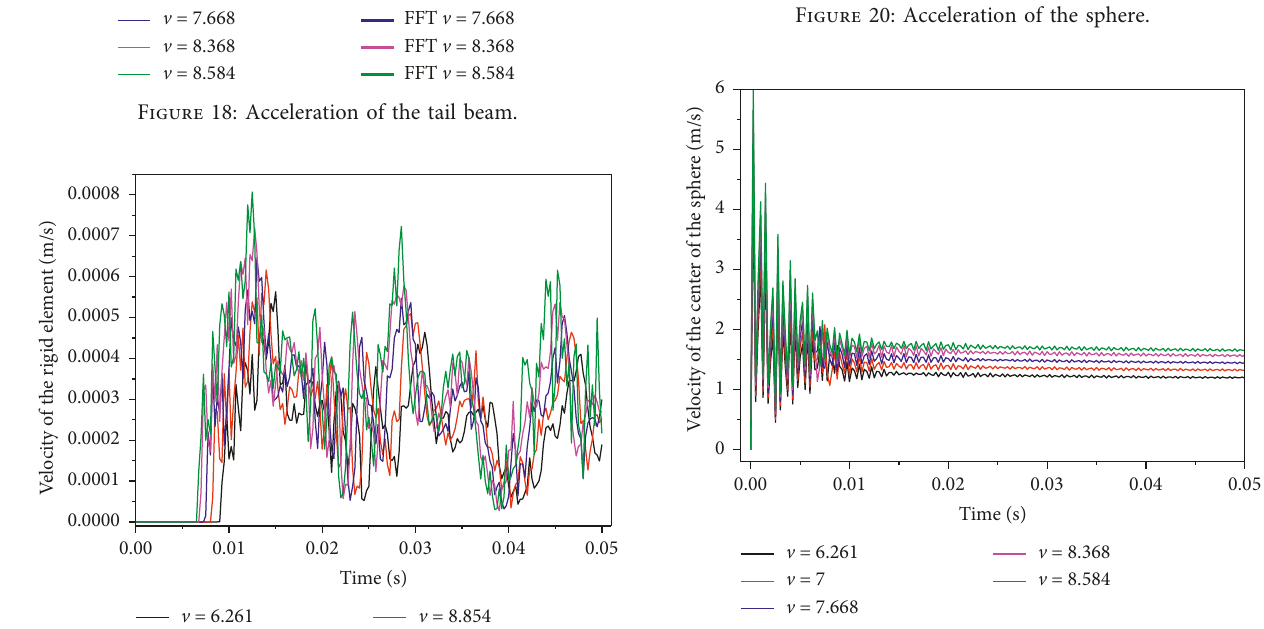
Figure 21: Velocity of the